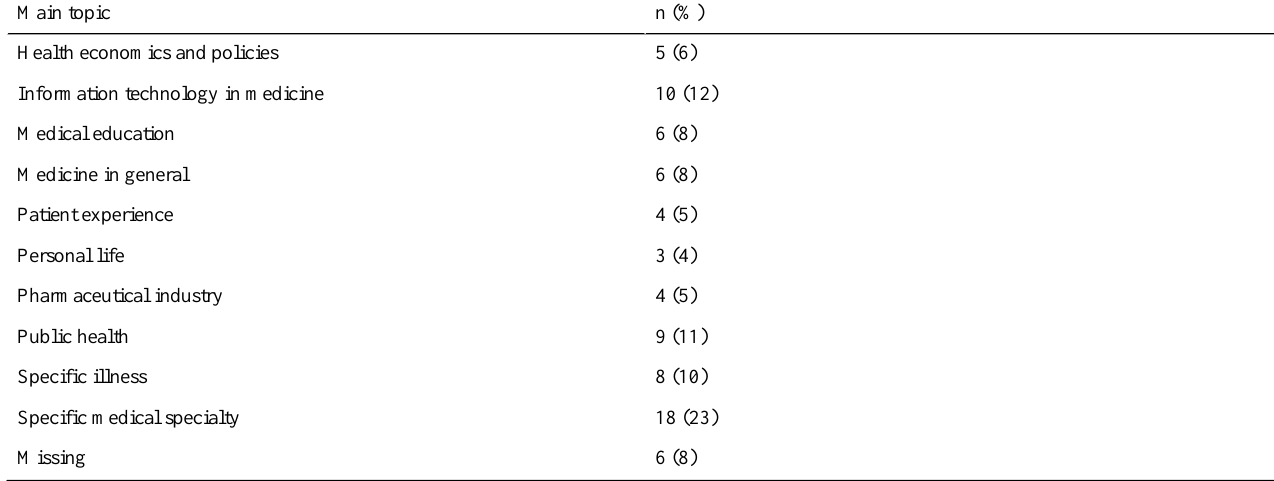
Table 3. Representation of main blog topics among the responding medical bloggers